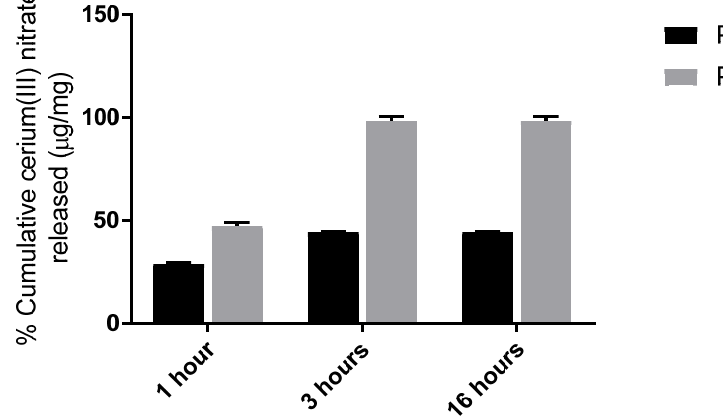
Figure 5. % Cumulative Ce(III) released per scaffold (µg/mg) over 16 h for 50 mg scaffold /mL diluent and 200 mg scaffold /mL diluent PEO/Ce(III) (n = 9).